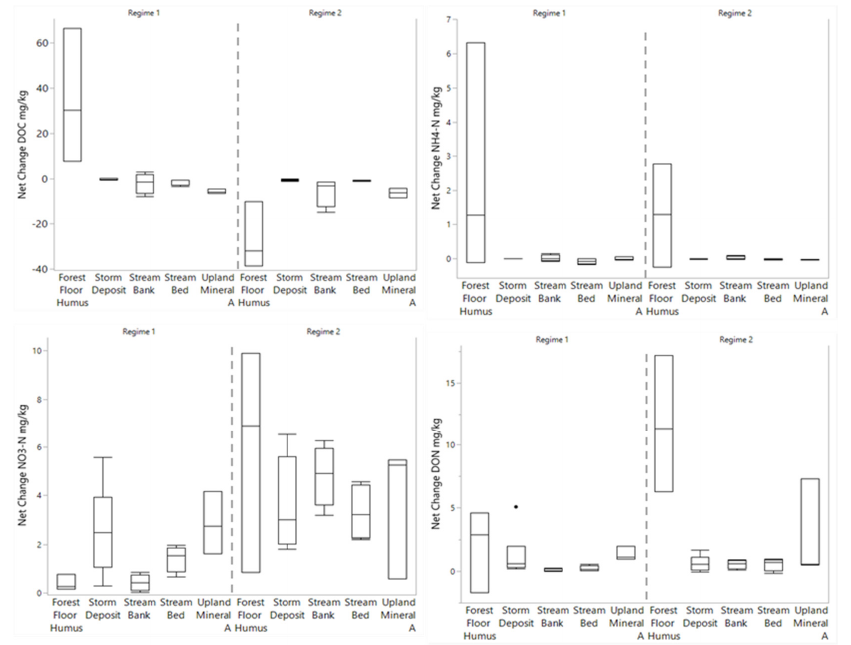
Figure 8. Comparison of net change in porewater ‐ dissolved N and C mass per unit weight of the source sediment. Negative values indicate consumption (sink) of the solute while positive values indicate release (source) of solutes.